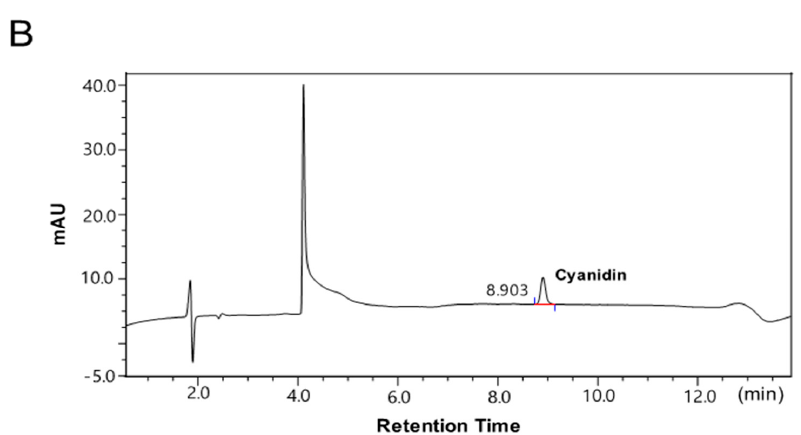
Figure 1. High-performance liquid chromatography (HPLC) profile of cyanidin from anthocyanin-rich extract from red Chinese cabbage (ArCC). HPLC chromatograms of a standard solution of 100 mg/L cyanidin ( A ) and cyanidin from ArCC ( B ) were recorded at 520 nm. mAU: milli Absorbance Unit.